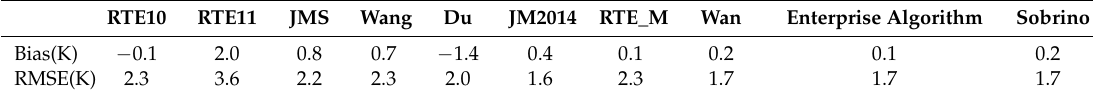
Table 7. Biases and RMSEs of LST retrieval with various